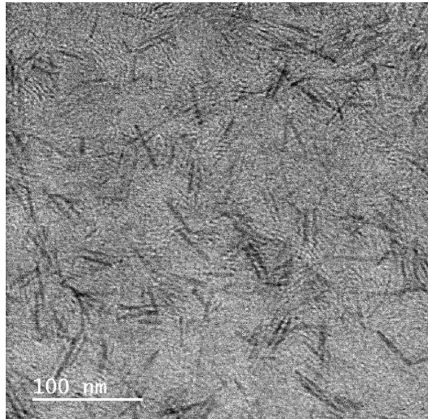
Fig. 2 FE‑TEM image of tungsten bronze nanorods (TBNRs)